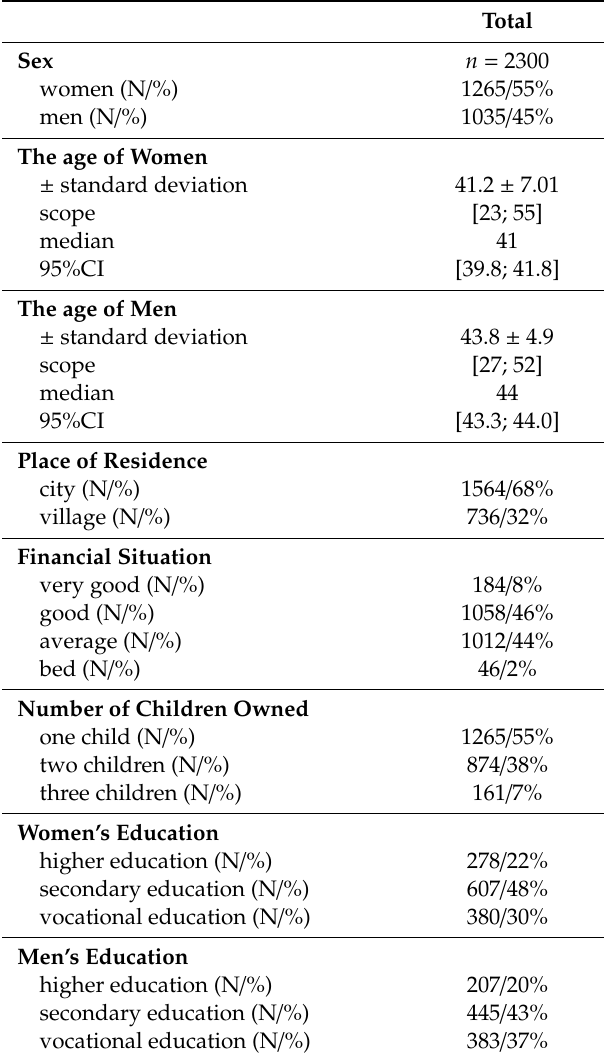
Table 1. Descriptive statistics of the examined group of